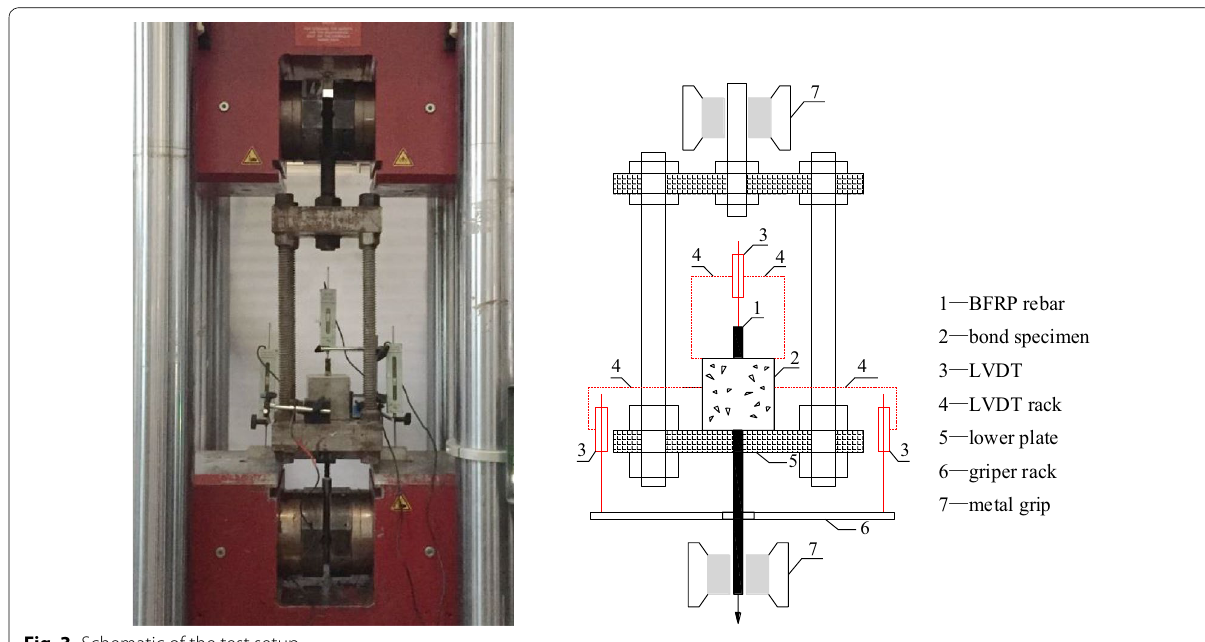
Fig. 3 Schematic of the test setup.